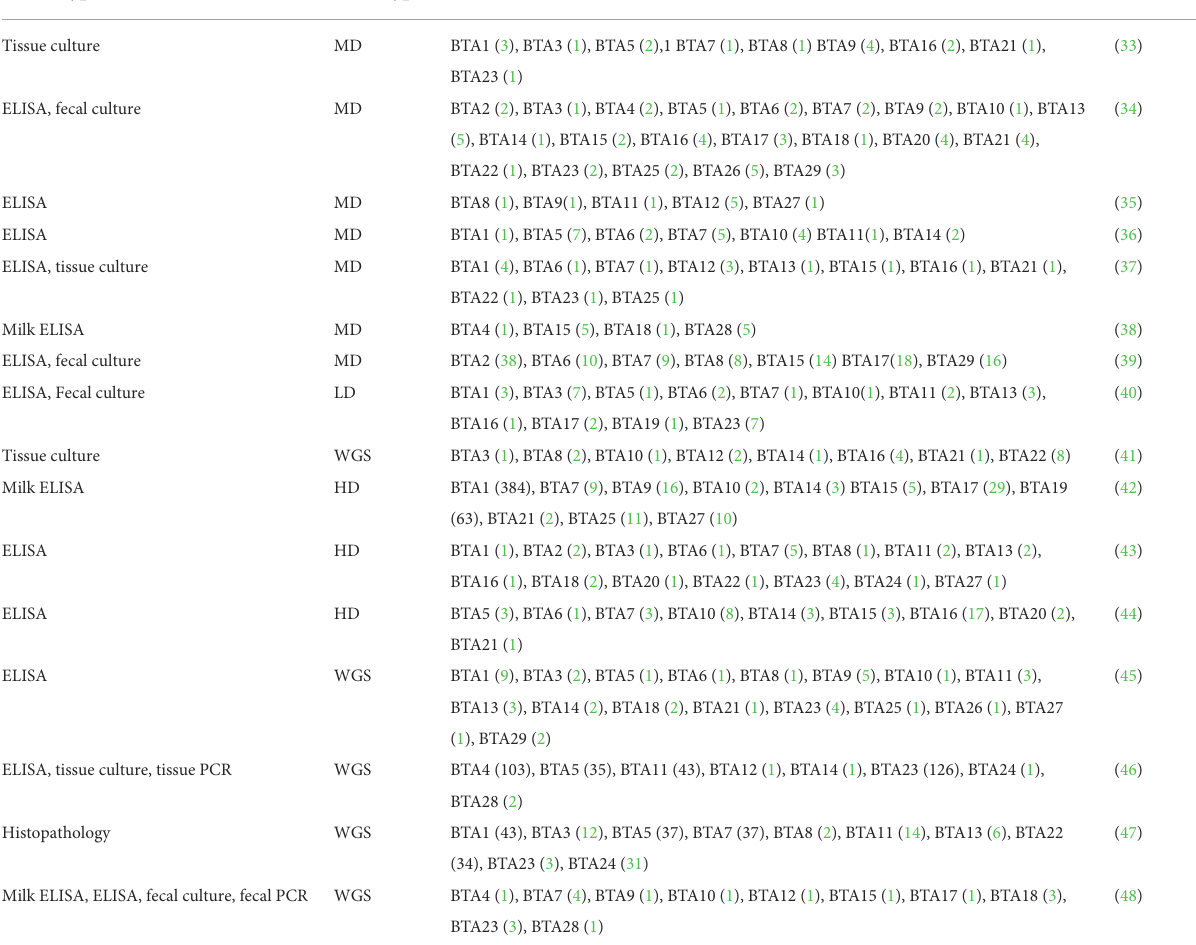
TABLE 1 Genome-wide association studies designed to identify SNPs associated with susceptibility to MAP